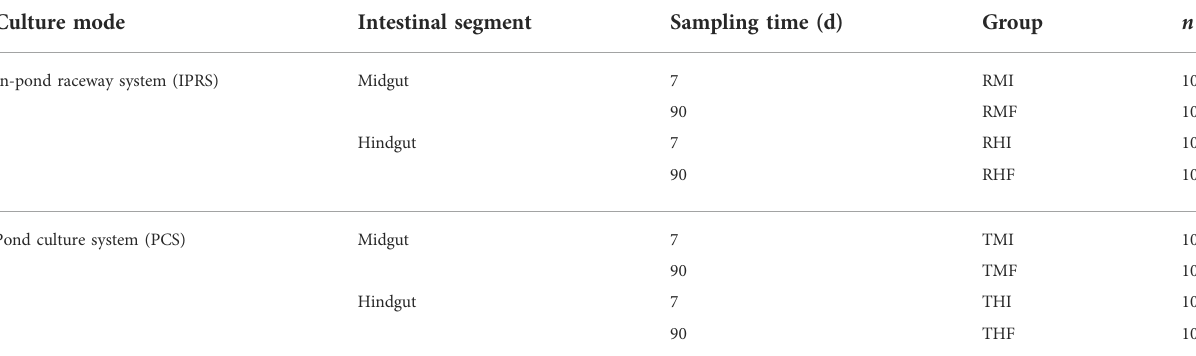
TABLE 1 Distribution of intestine samples from genetically improved farmed tilapia, under two culture modes. RMI = IPRS, midgut, D7; RMF = IPRS, midgut, D90; RHI = IPRS, hindgut, D7; RHF = IPRS, hindgut, D90; TMI = PCS, midgut, D7; TMF = PCS, midgut, D90; THI = PCS, hindgut, D7; THF = PCS, hindgut,